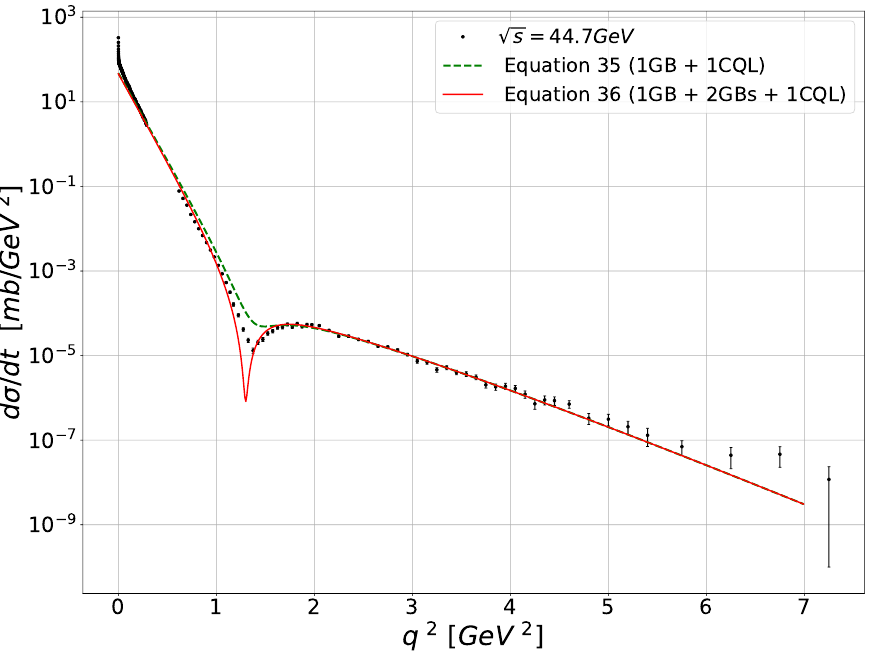
√ s = 44.7 GeV. Black dots are experimental